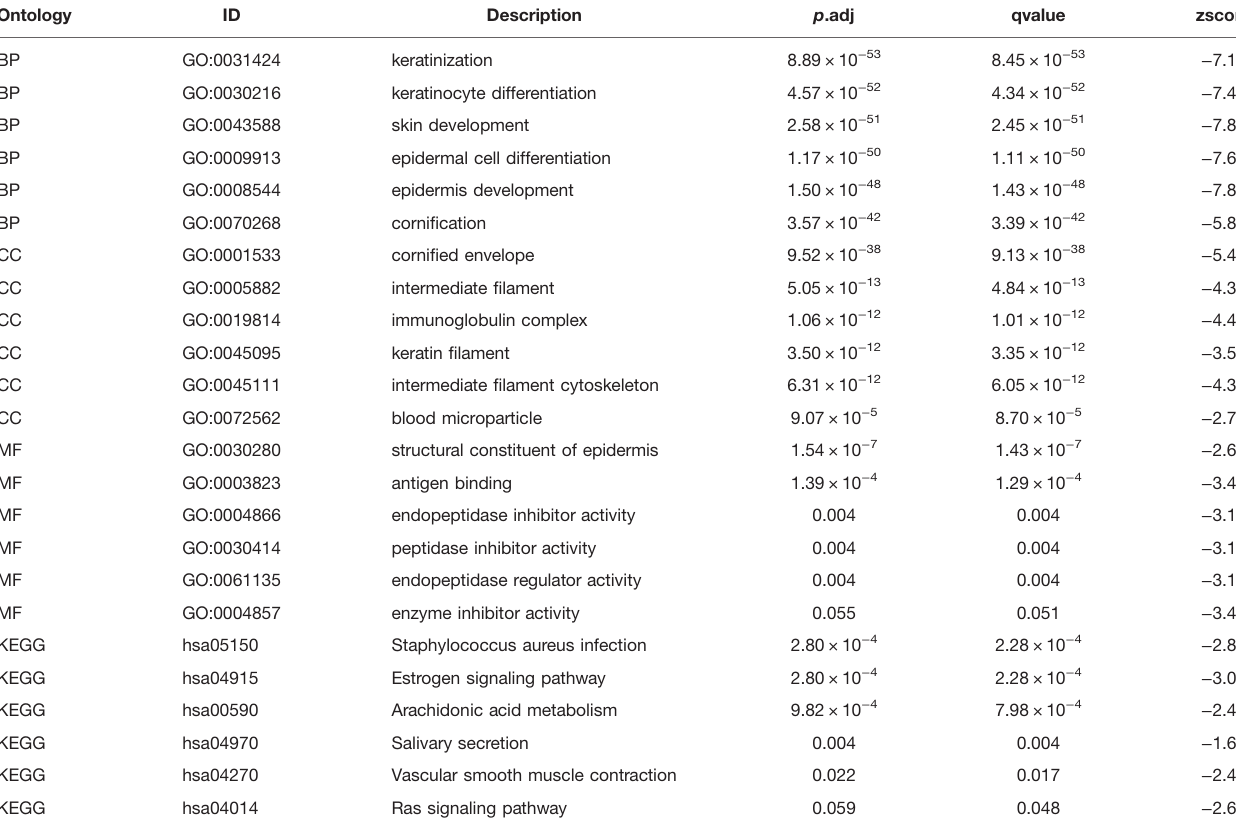
TABLE 1 | GO/KEGG functional enrichment of TIM-related DEGs.